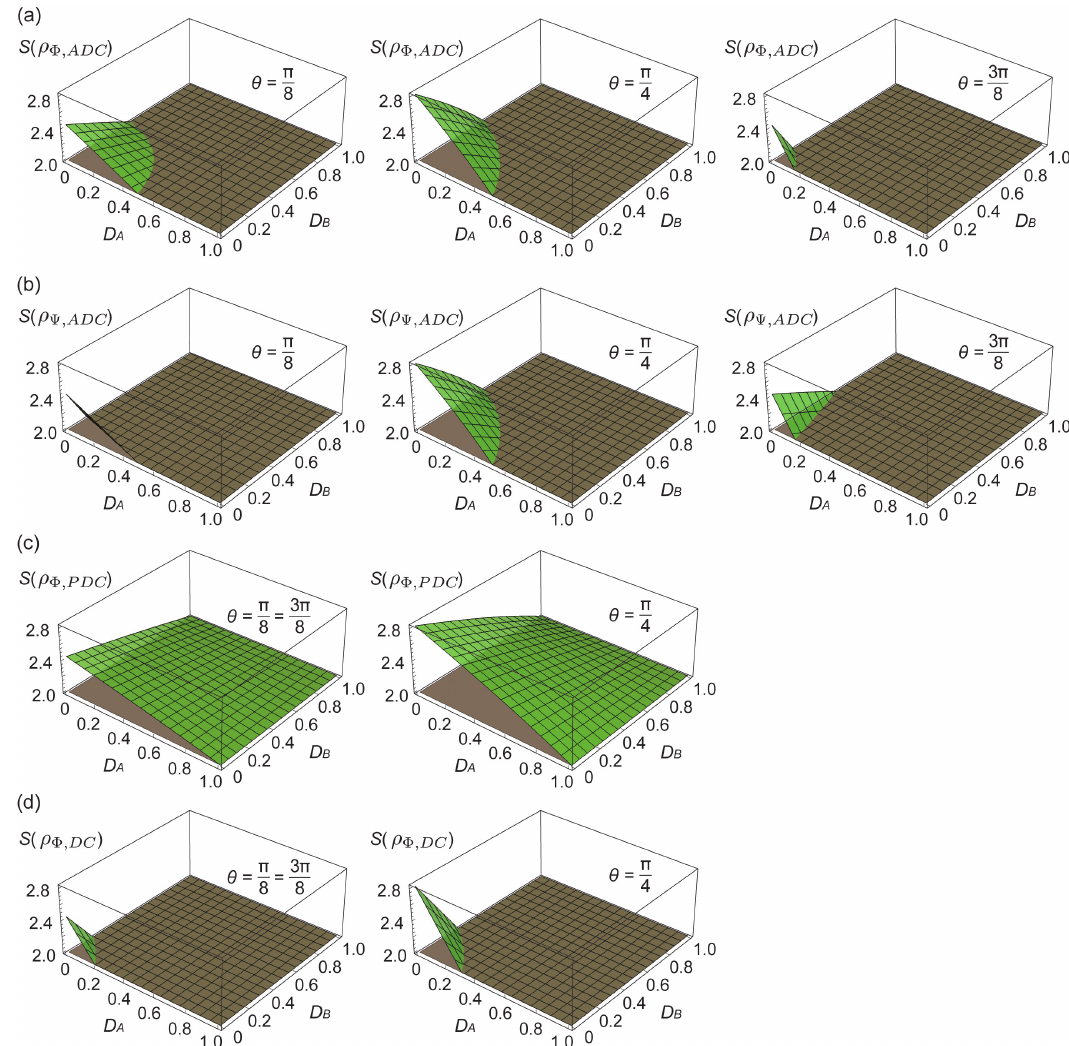
Figure 4. Theoretical results of Bell parameter (Green) as functions of D A and D B with θ = π /8, θ = π /4, and θ = 3 π /8 for ( a ) ρ Φ , ADC , ( b ) ρ Ψ , ADC , ( c ) ρ Φ , PDC , and ( d ) ρ Φ , DC . Above S = 2 planes indicate the existence of Bell nonlocality. As the Bell parameter shows a symmetric behavior with respect to θ = π /4 for ρ Φ , PDC and ρ Φ , DC , the Bell parameter shows the same results for θ = π /8 and θ = 3 π